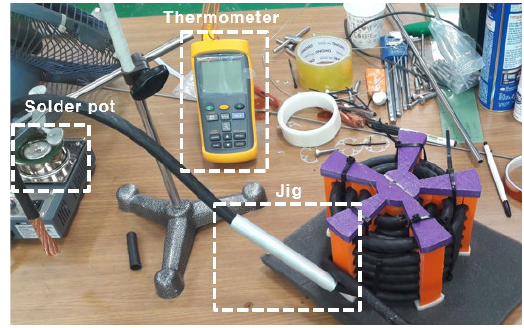
Figure 7. Soldering setup.